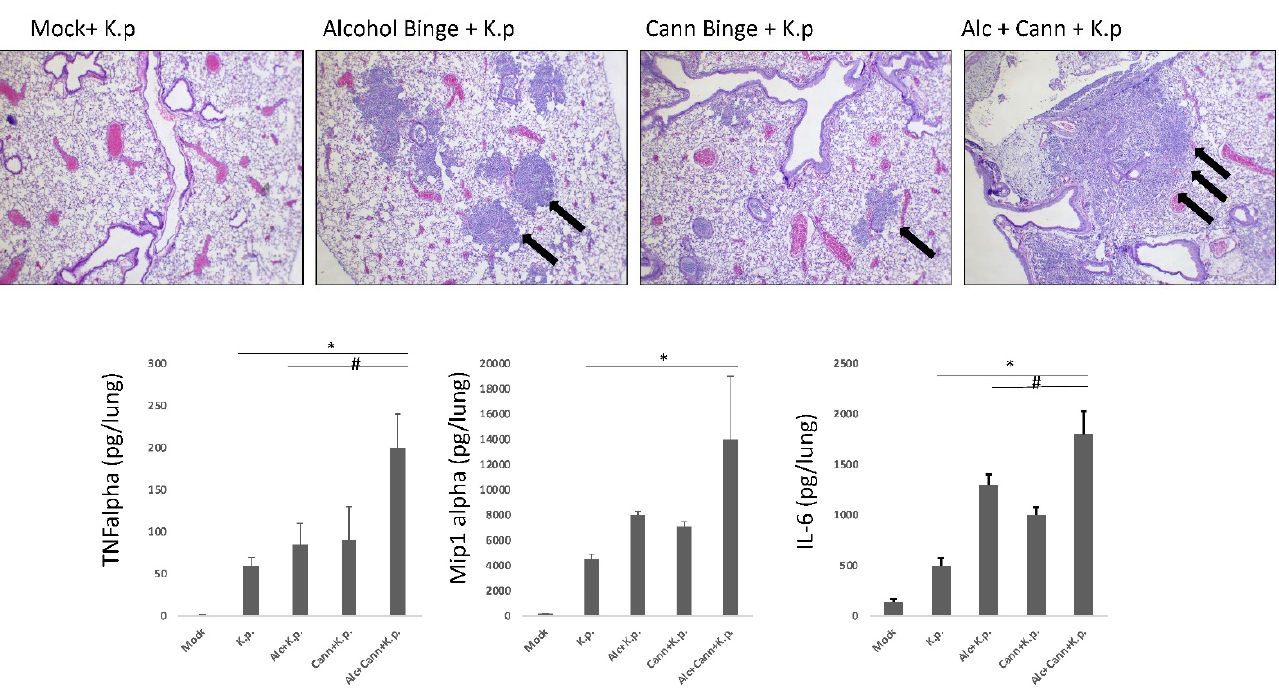
Figure 1. Mouse lung histopathology and inflammatory protein secretion. Increased neutrophilic influx and damage is present in lungs of mice exposed to substances prior to pneumonia challenge. Formalin fixed mouse lung sections are stained with H&E and magnified by 40×. Cellular influx and consolidation are demonstrated by purple staining, and inflammation is indicated with arrows. Inflammatory cytokine secretion measured from bronchioalveolar lavage fluid, using IL-6, TNF alpha and Mip1-alpha ELISAs (BD Bioscience). # indicates significant increase over single substance + K.p., * indicates significance over K.p. alone. K.p: Klebsiella pneumoniae , cann: cannabinoids, alc: alcohol.